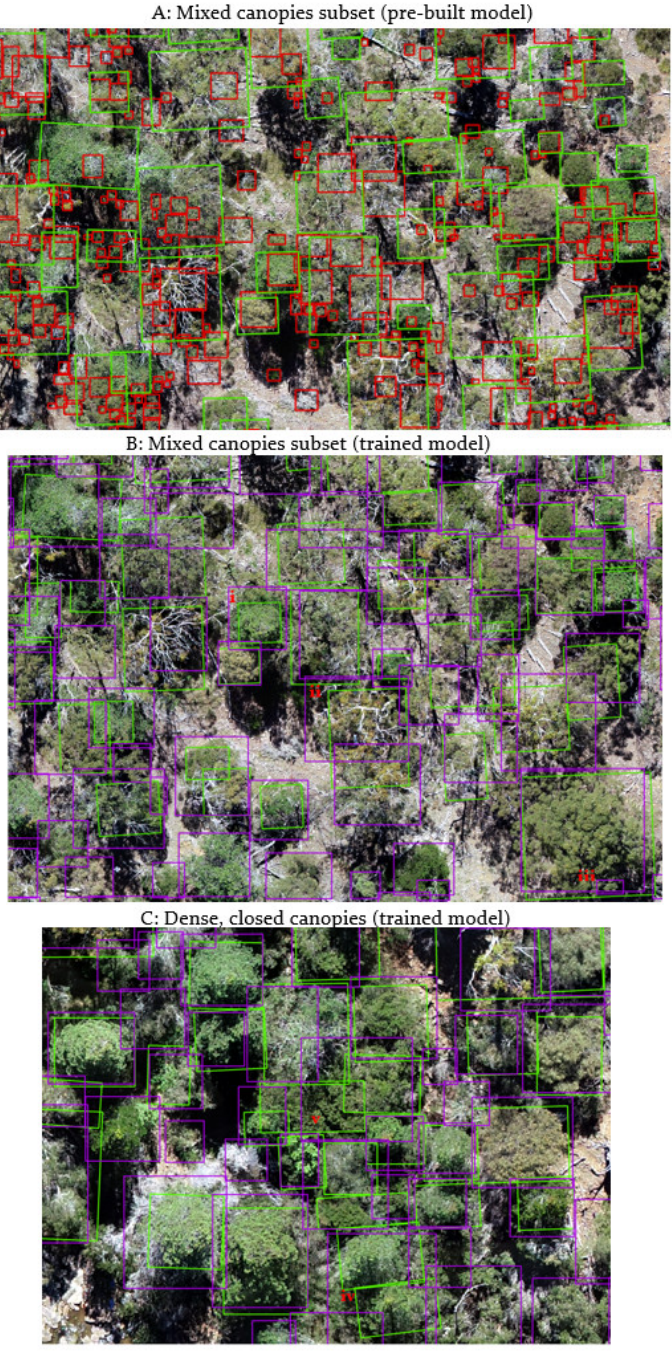
Figure 6. Predictions from DeepForest overlaid with manually delineated test data (in green). ( A ) Bounding box predictions (in red) using the DeepForest pre-built model overlaid with the manually delineated test data. ( B ) Predictions from DeepForest model trained with data from the site. Digitizing tree extent was challenging in overlapping canopies. Additionally, in several instances, (i) the predicted extents were larger than the digitized test box. Branching canopies were split into multiple boxes (ii). The edges of canopies were detected in several, small spurious polygons (iii). ( C ) In the closed canopy Callitris forest, crowns close together were grouped within a box (iv). Digitizing dense Melaleuca pustulata scrub extent in bounding box format was also challenging and caused mismatches in the predicted results (v). However, all tree crowns around this low-lying scrub were detected in this instance.